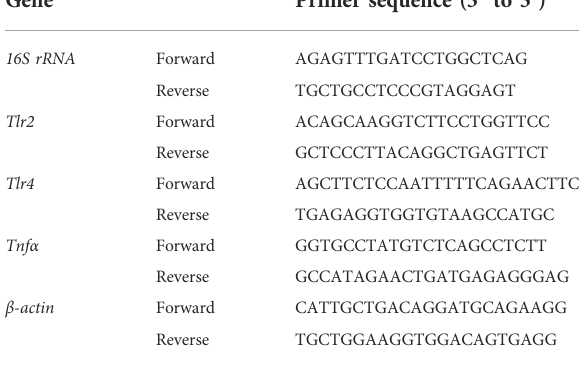
TABLE 2 Primer sequences used for real-time